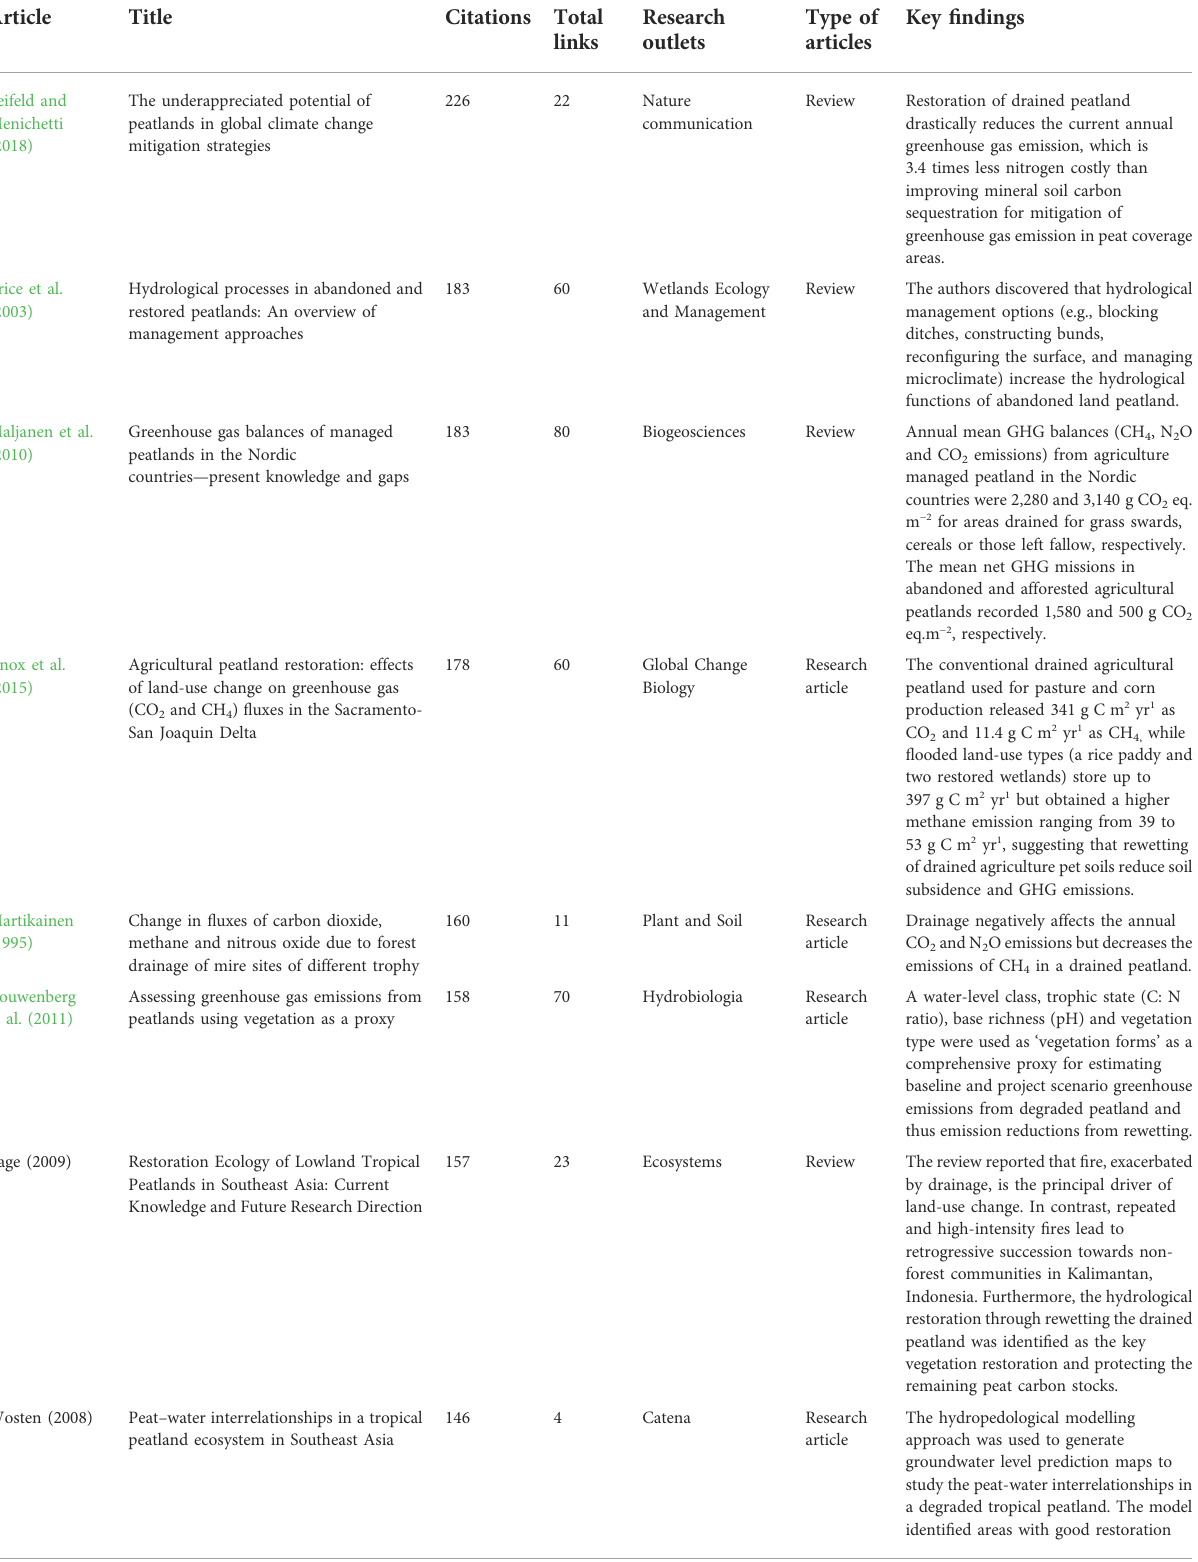
TABLE 4 Highly cited document in the restoration of degraded peatland research